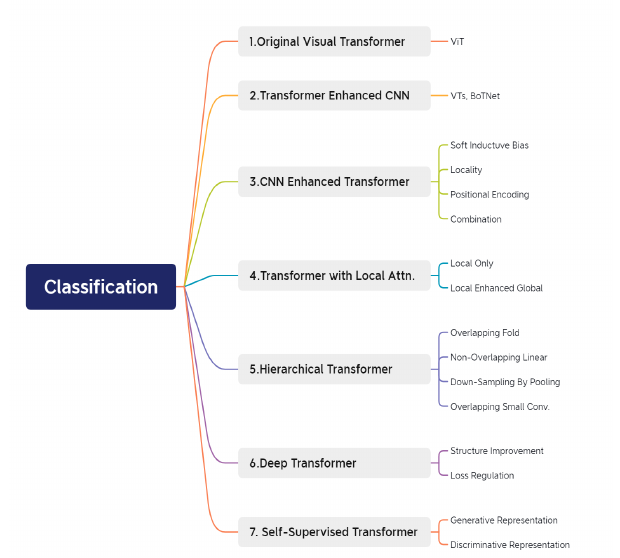
Figure 1. Vision Transformer for